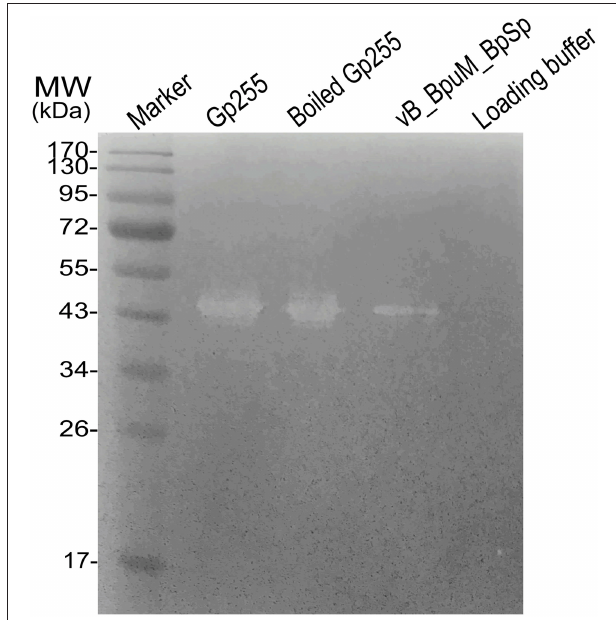
FIGURE 5 | Analysis of peptidoglycan-hydrolyzing activities of phage vB_BpuM_BpSp. The purified phage vB_BpuM_BpSp was mixed with loading buffer and boiled at 100 ◦ C for 10 min before separating them by SDS-PAGE. The purified Gp255 was mixed with loading buffer. After that, the unboiled (indicated as “Gp255”) and boiled (indicated as “Boiled Gp255”) proteins were separated by SDS-PAGE. The sterilized crude cell extracts of GR8 was added into the gel for lytic activity assay. The lane loaded with 1 × Loading buffer were used as control.